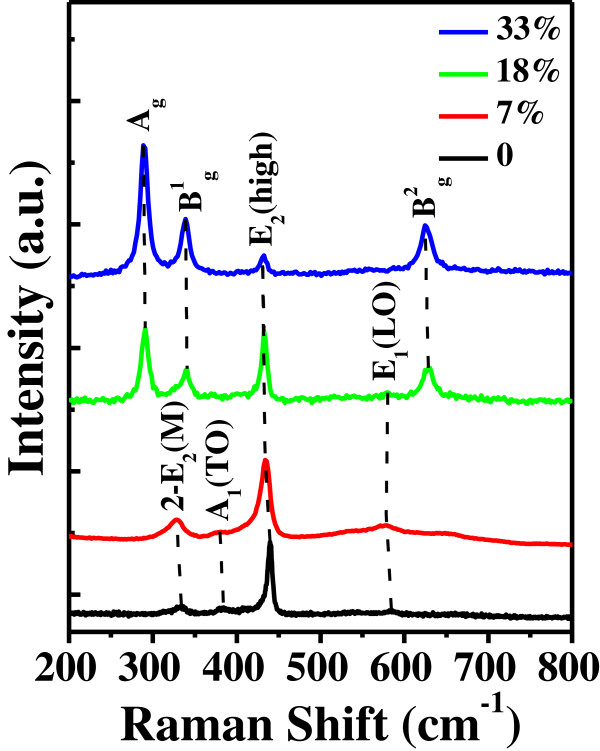
Raman spectra. Raman spectra of undoped ZnO and Zn1−xCuxO samples with the Cu contents of 7%, 18%, and 33%.